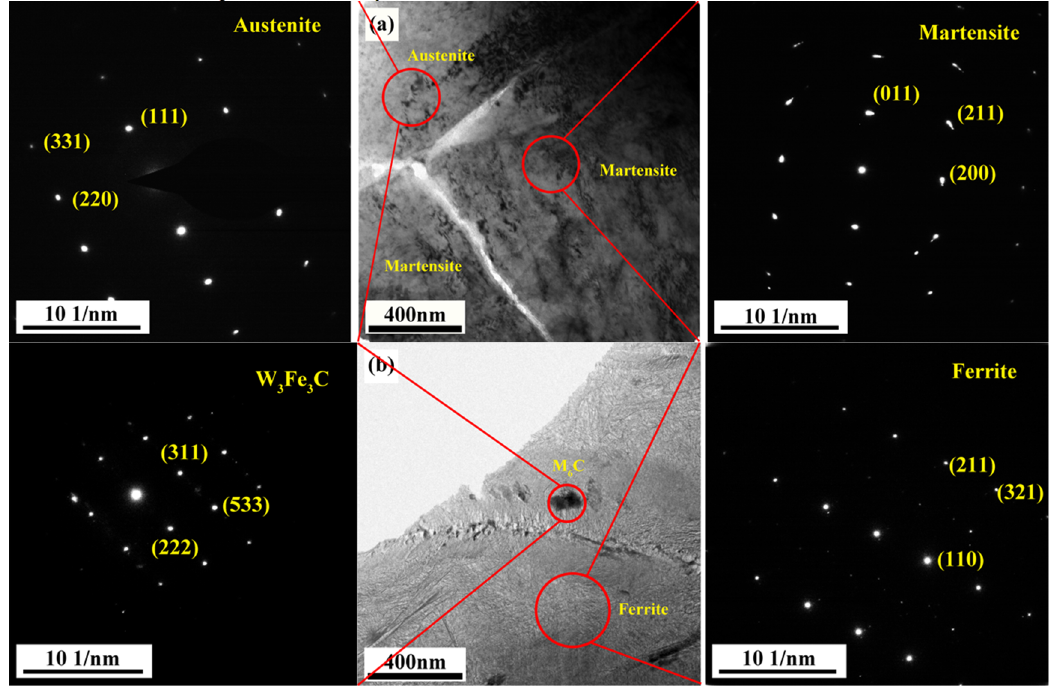
Figure 8. TEM and Selected Area Electron Diffraction Diagram of M42 HSS under different Tempering Temperatures: ( a ) 550 °C, ( b ) 700 °C.